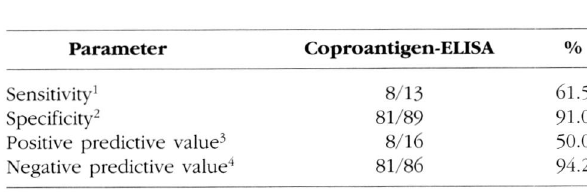
Table IV. - Sensitivity, specificity, positive and negative predictive- values of coproantigen-ELISA test for E. granulosus detection in 94 stray dogs and eight red foxes from northern